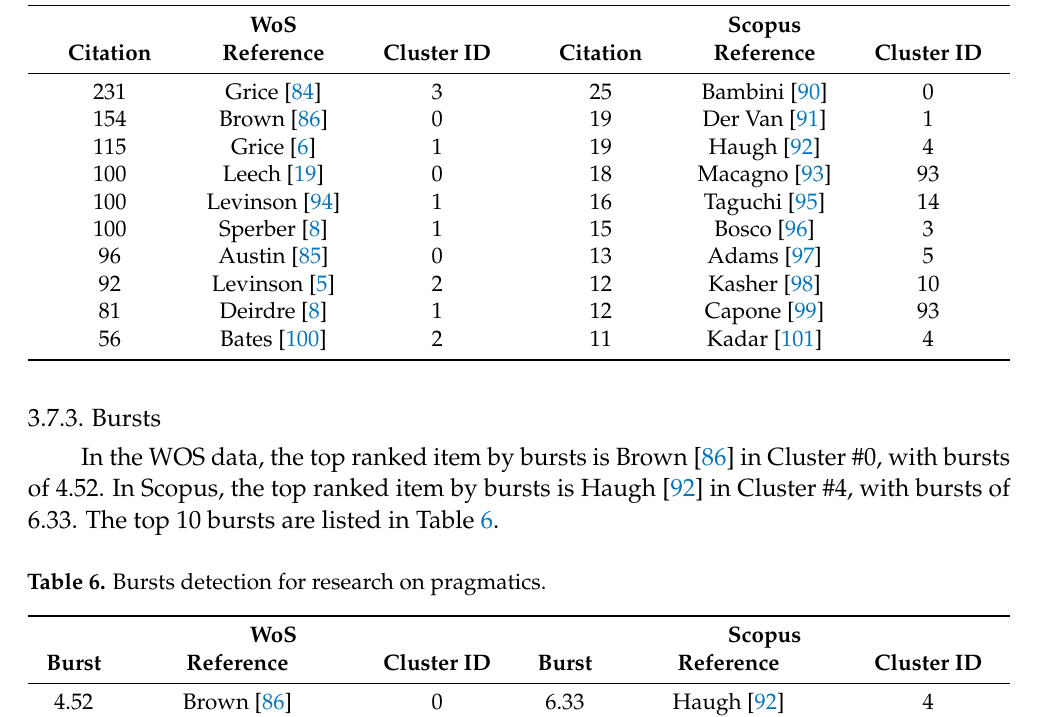
Figure 11. Co-citation by source, cited author network visualisation. ( A ) (WOS: source). ( B ) (WOS: cited authors). ( C ) (Lens: citation by source). Table 5. Citation counts for pragmatics research.